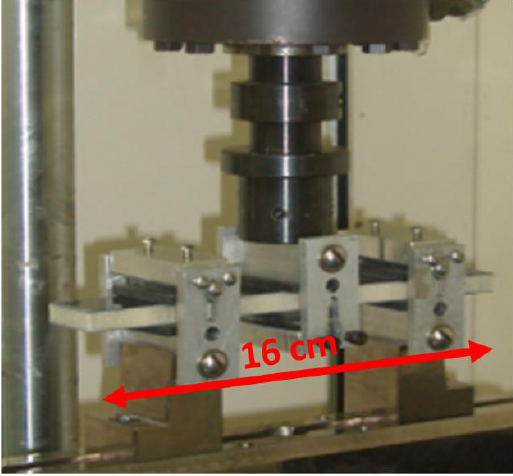
Figure 11. Material MTS 810 test system.